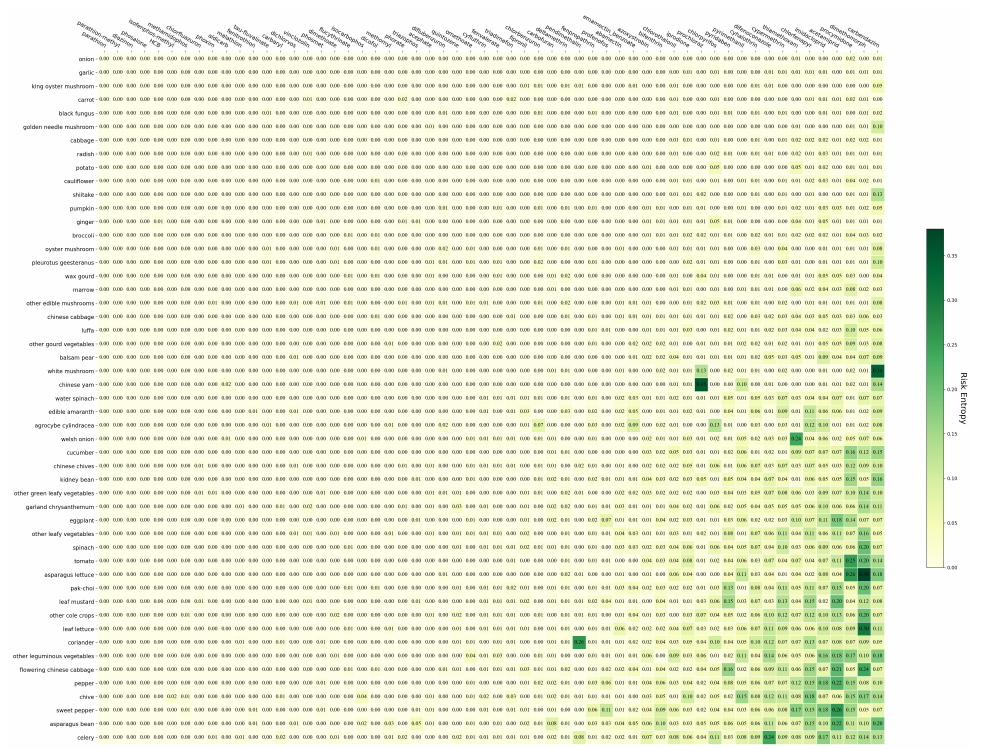
Figure 5. Heat map of the residual rate of pesticide, the row labels are the names of 51 agricultural products and the columns are labelled with 58 indicators of pesticide residue detection. Darker colours indicate that a greater proportion of the sample was detected for the corresponding